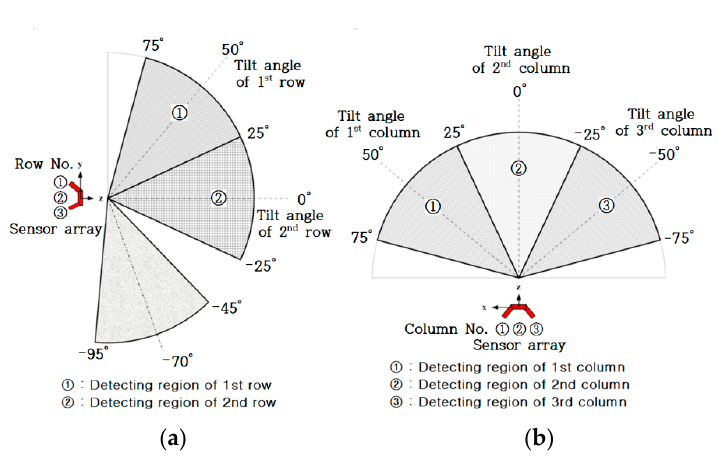
Figure 6. Arrangement of the seven ultrasonic sensors; ( a ) Elevation direction; ( b ) Azimuth direction.